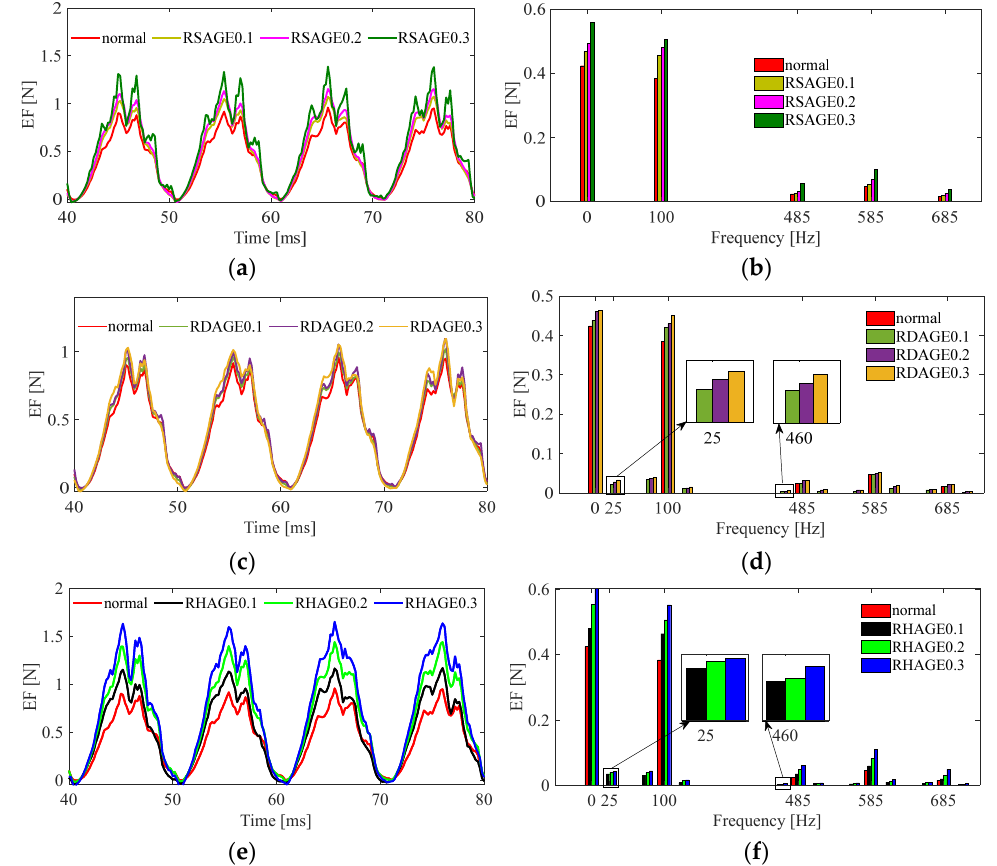
Figure 6. The end winding EF by FEA: ( a , b ) the time domain and frequency domain in RSAGE; ( c , d ) the time domain and frequency domain in RDAGE; and ( e , f ) the time domain and frequency domain in RHAGE.